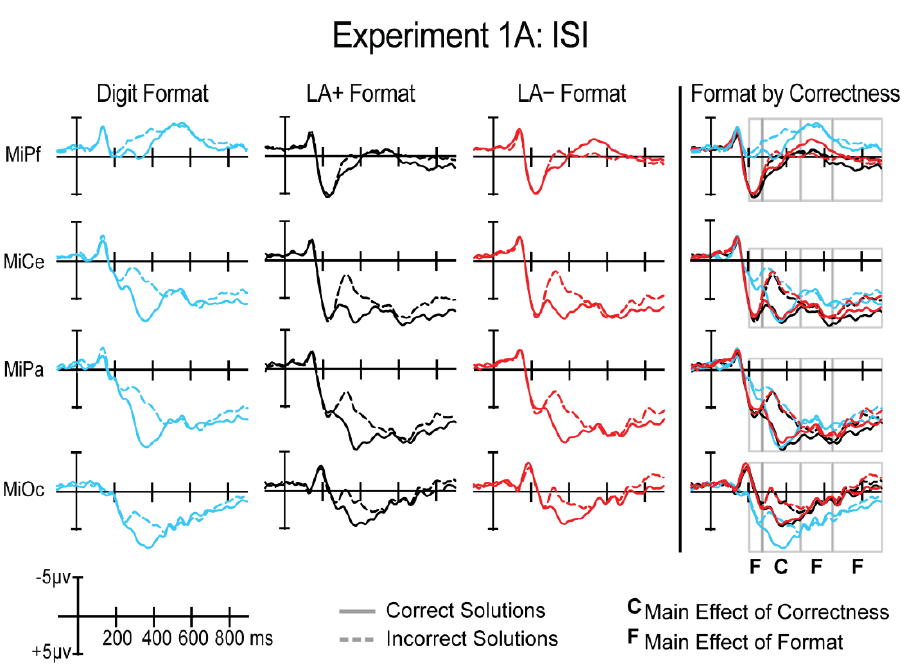
Figure 4. Grand averaged ERPs time-locked to Arabic digit solution onset for multiplication problems presented as digits (blue), spoken number words in LA+ (black), and spoken number words in LA − (red). Representative midline electrodes are shown. Responses to correct solutions are represented as solid lines and responses to incorrect solutions are represented as dotted lines across all formats. Traces on the far right depict the overlap of all three formats, highlighting consecutive time windows used for analysis in the grey boxes ( n = 29). Significant effects are indicated below the windows; p < 0.01.